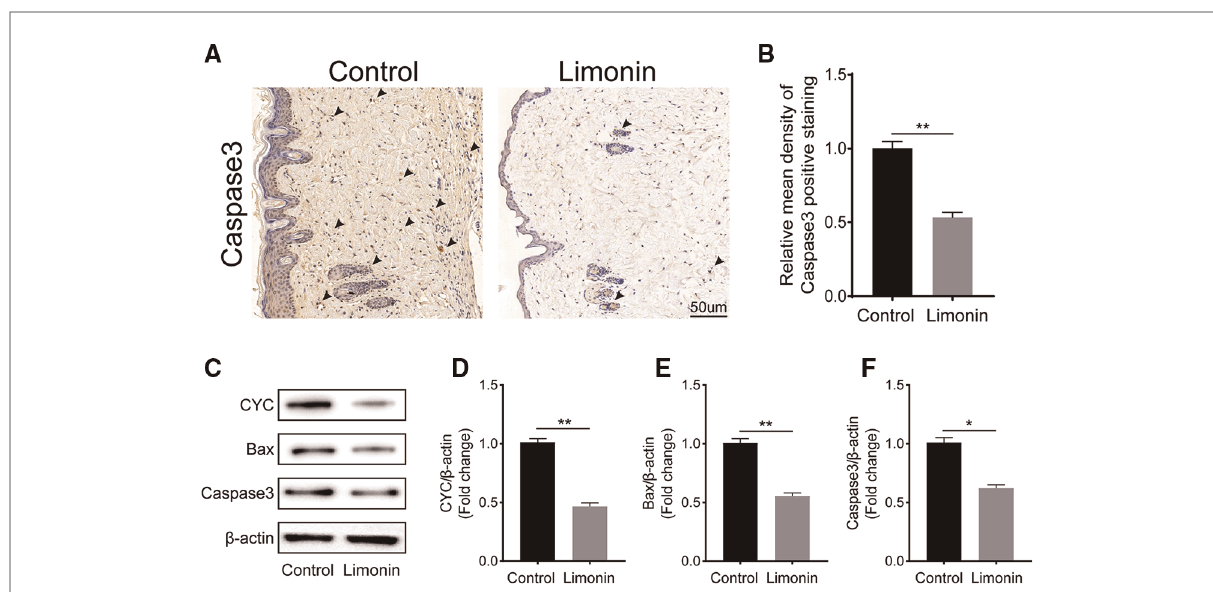
FIGURE 4 Limonin alleviates apoptosis in the ischemic area of the fl aps. ( A ) Caspase 3 levels of the fl aps in the control and limonin groups as assessed by immunohistochemistry (original magni fi cation ×200; scale bar, 50 µm). ( B ) Histograms of optical density values for CASP3 by immunohistochemistry in each group. ( C ) Western blotting for Bax, CYC, and Caspase 3 expression in the skin fl aps of the control and limonin groups. Gels were electrophoresed under the same experimental conditions, and cropped blots are shown here. ( D – F ) Histograms of the optical density values of Bax, CYC, and Caspase 3 in the two groups as measured using Western blotting. Data are mean±standard error of the mean, n =6 per group. * P <0.05 and ** P <0.01, vs. control group.